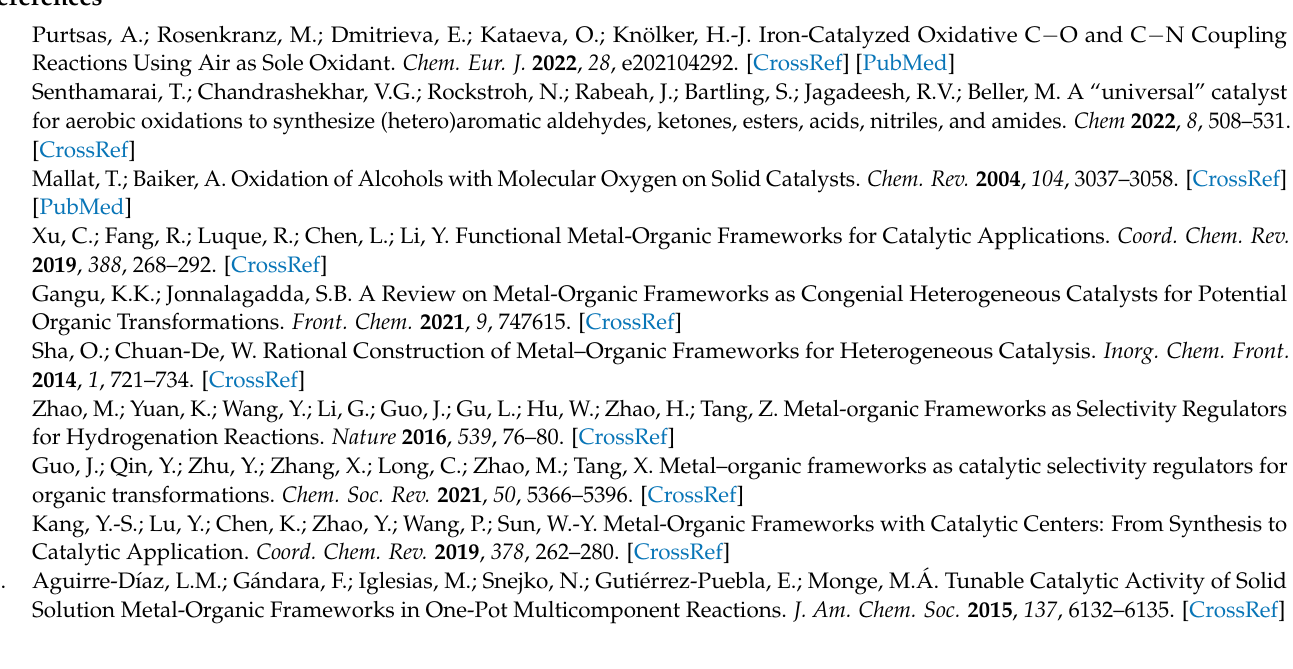
Figure S9. 1 H NMR spectrum of 1,2-bis(4-bromophenyl)-2-hydroxyethanone in CDCl 3